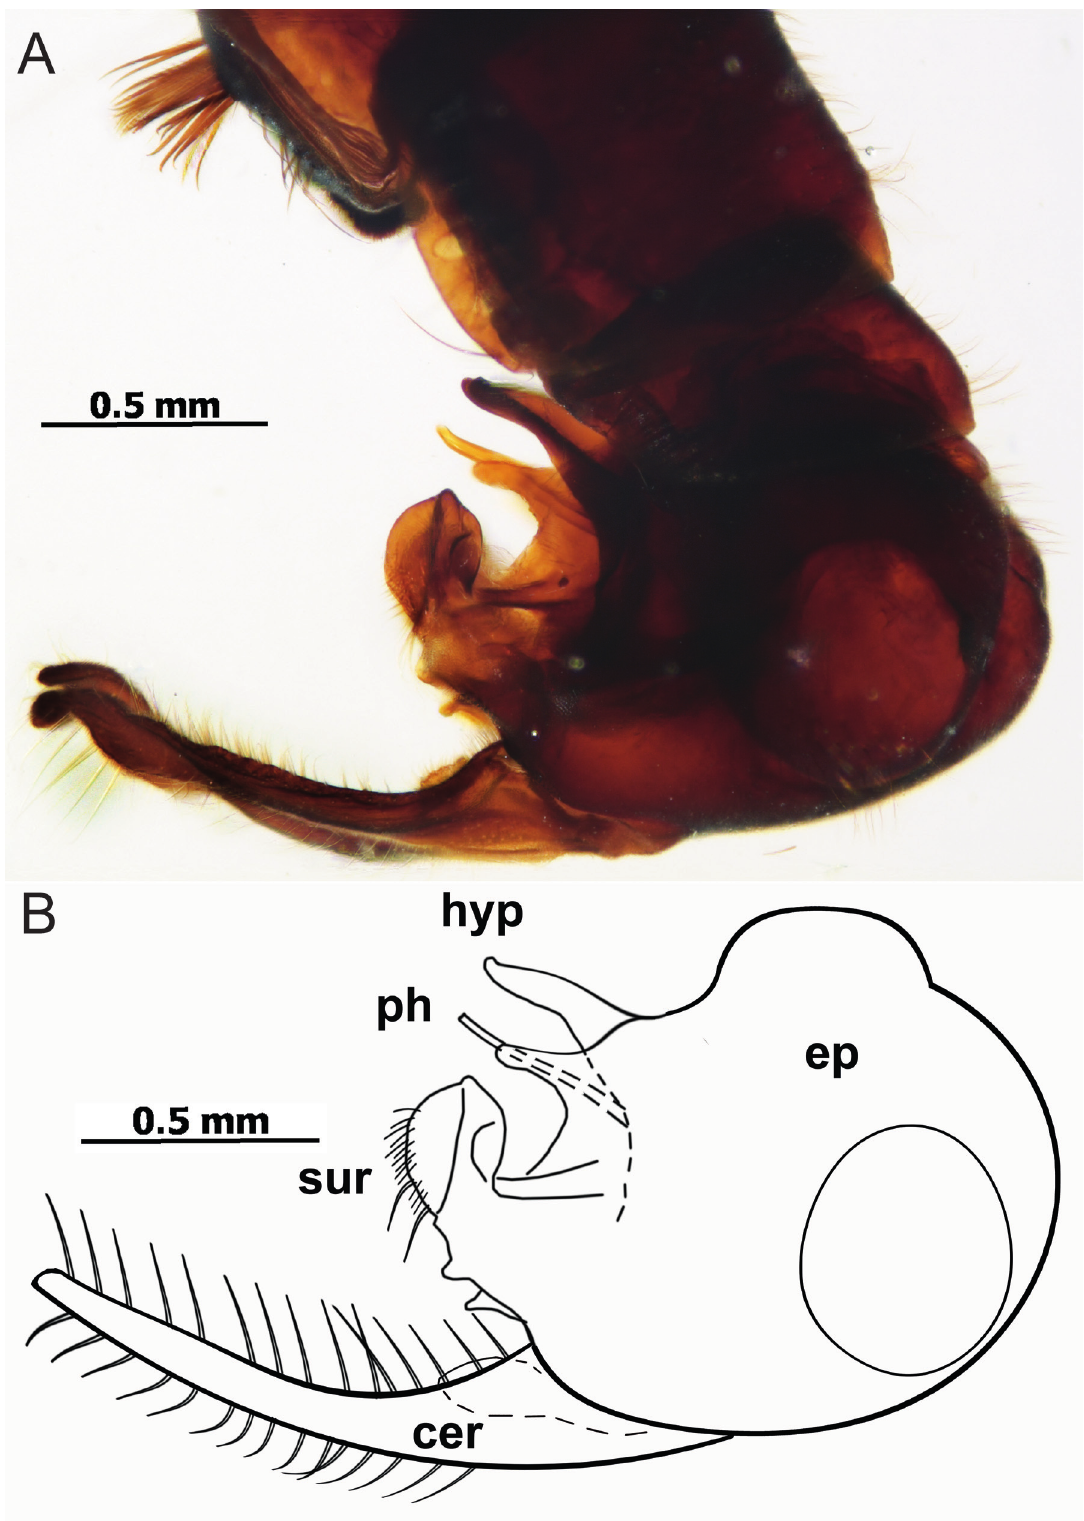
Fig. 3. Diostracus ( Sphyrotarsus ) kustovi sp. nov. Male holotype. A . Apex of abdomen and hypopygium. B . Hypopygium. Abbreviations: cer – cercus, ep – epandrium, hyp – hypandrium, ph – phallus, sur –